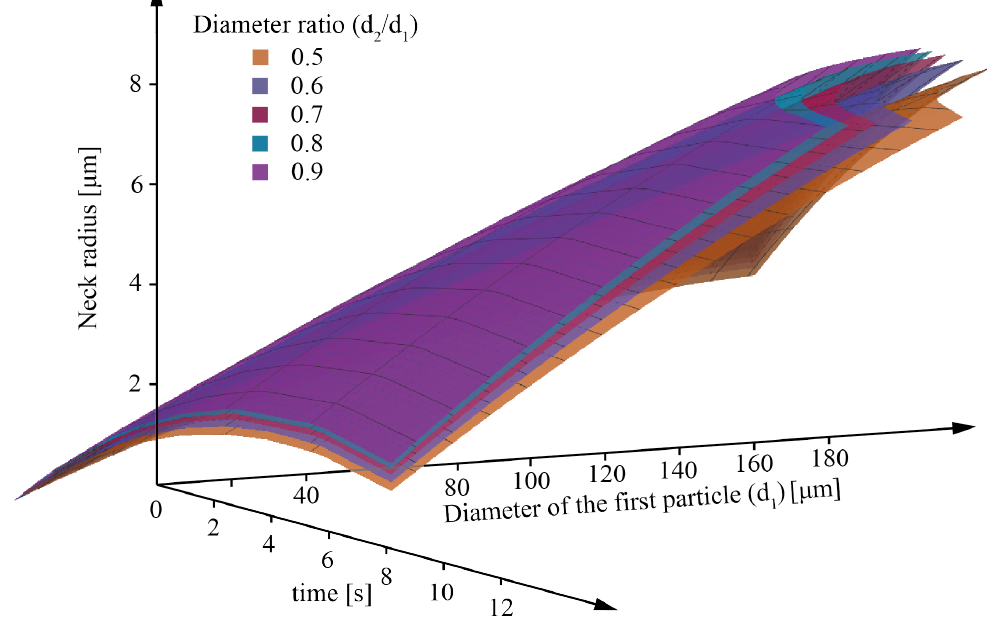
Figure 2. Surface plot of the neck radius obtained at each diameter ratio and simulation time. Table 7. Response surface regression equation for each diameter With the same diameter ratio, the coefficients of the surface response highlight a strong dependence of the neck radius on the simulation time and the diameter of the par- ticles. On the contrary, the second order coefficients such as d 12 or t ⋅ d 1 have a reduced impact on the neck radius dimension. Table 7. Response surface regression equation for each diameter ratio.